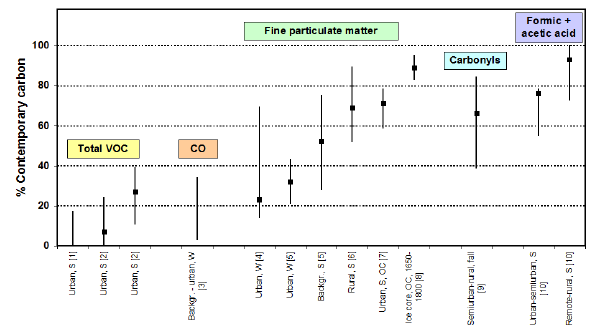
Fig. 3. Relative amount of contemporary carbon in measurements made in different situations and seasons. Ranges are shown together with the median value. Summer is indicated by “S” and winter by “W”. The plot is an update of the one shown in Larsen et al. (2001). “Total VOC” are volatile organic compounds excluding methane. [1] (Klouda et al., 1996) [2] (Klouda et al., 2002) [3] (Klouda and Connolly, 1995) [4] (Klinedinst and Currie, 1999a) [5] (Glasius et al., 2010) [6] (Lewis and Stiles, 2006) [7] (Szidat et al., 2009) [8] (Jenk et al., 2006) [9] (Larsen et al., 2001) [10] (Glasius et al., 2001).